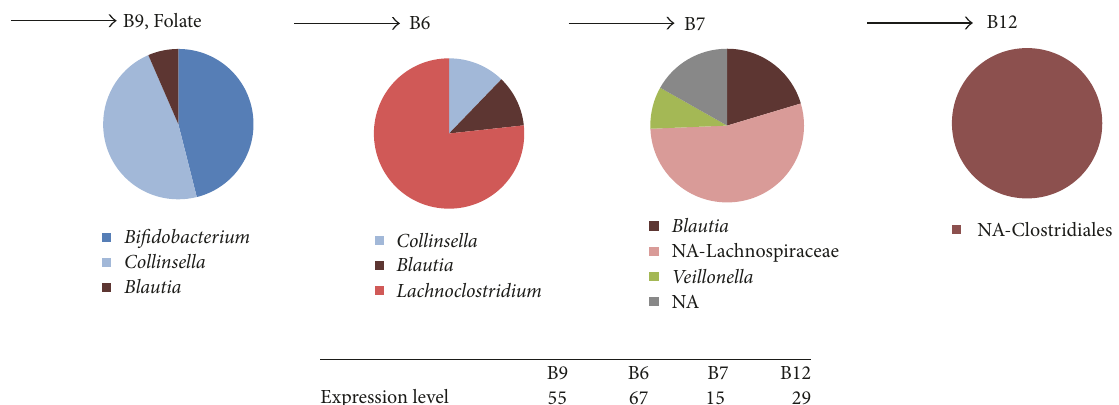
Figure 4: Relative taxonomic profiles based on the final enzyme for the corresponding vitamin metabolism of sample T2 M. KEGG numbers for the final step in the corresponding vitamin pathways for this figure are K00287 (B9, Folate), K00868 (B6); K01012 (B7, Biotin); K02233 (B12). Table 3: Overview of the expressed PTS and ABC transport modules involved in sugar transport in sample T2 M. 𝑝 values and adjusted 𝑝 values indicate the likelihood of a KEGG module to be enriched on a background of amongst all detected KEGG